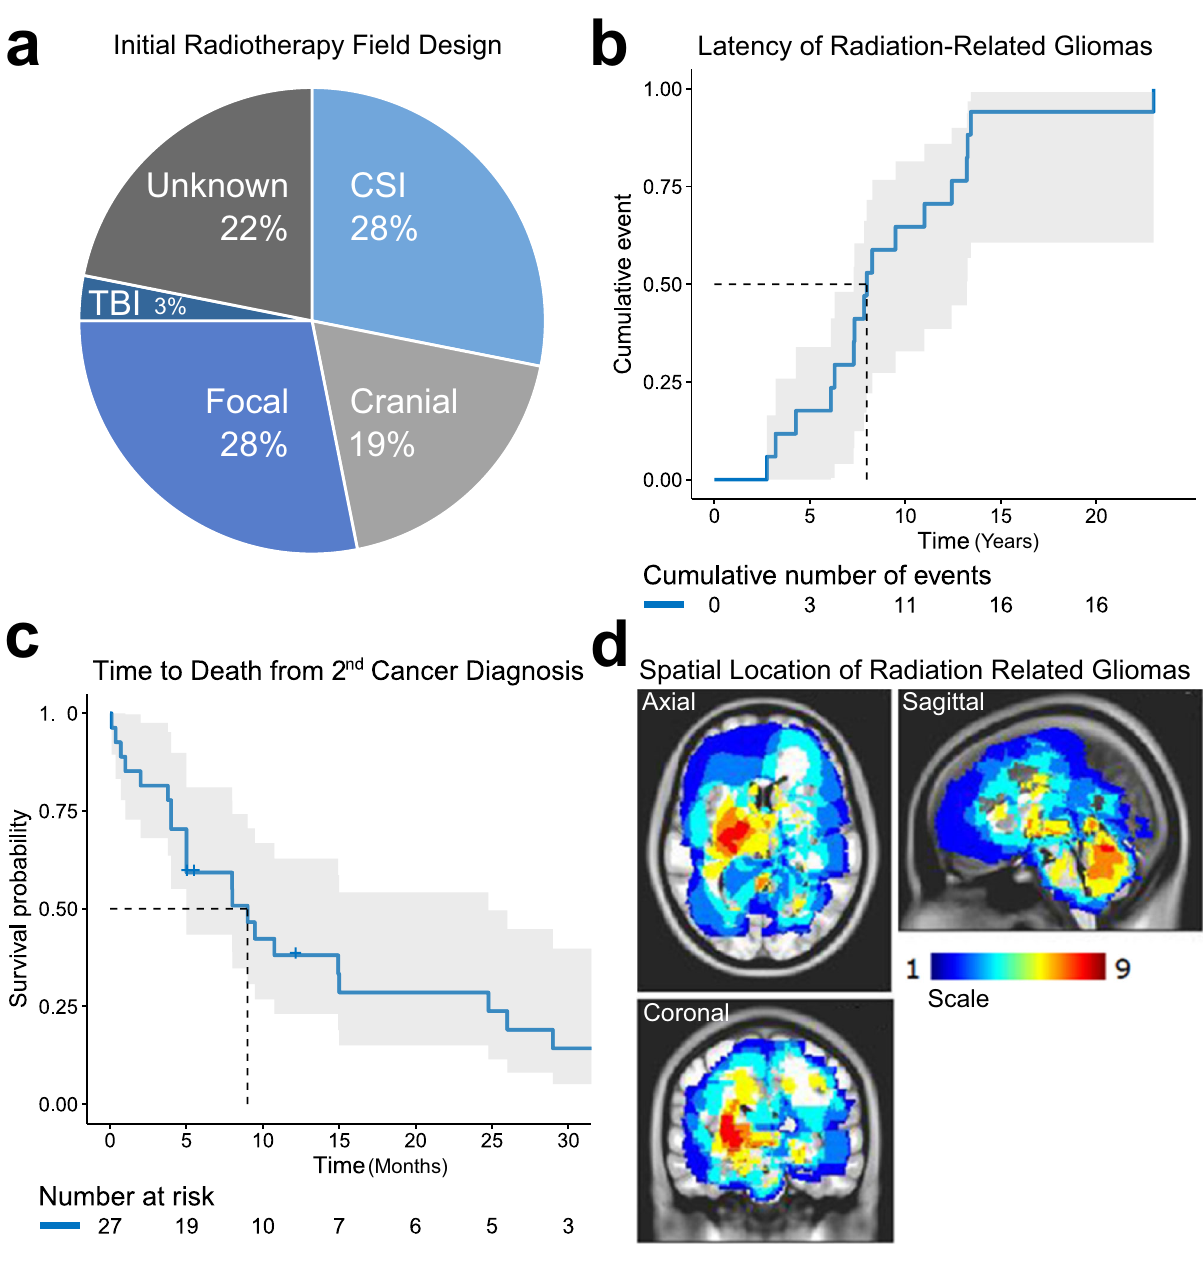
Fig. 1 RIG cohort characteristics. a Radiotherapy fi eld type used to treat the initial (pre-RIG) cancer. b Time to the diagnosis of RIG from initial cancer diagnosis. c Time to death following RIG diagnosis. Two patients survived beyond 35 months but were deceased at study closure. d Anatomic location of RIG. Color scale indicates the number of cases anatomically overlapping at each point in space. RIG radiation-induced high-grade glioma, CSI craniospinal irradiation, TBI total body irradiation. The gray region around each line in ( b , c ) represents the 95% con fi dence interval around the